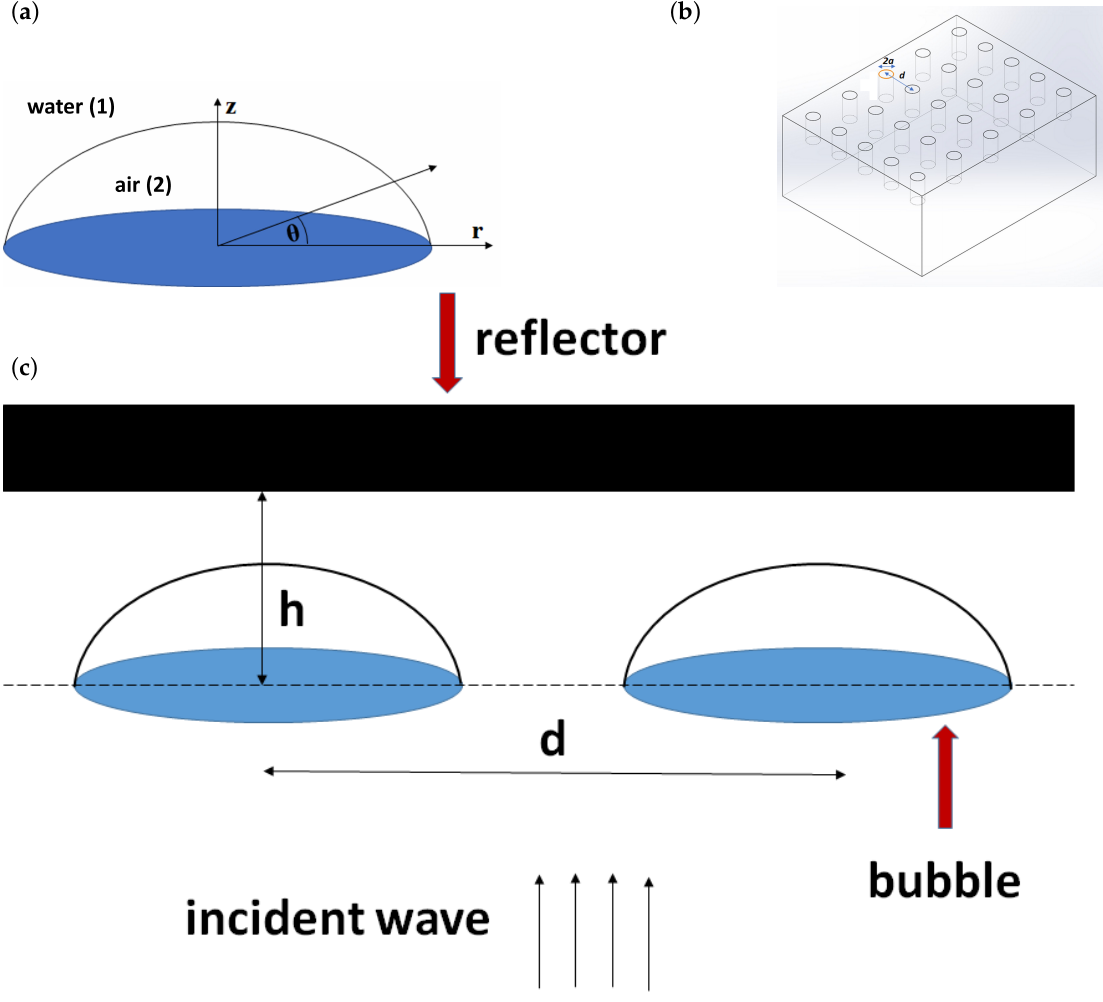
Figure 1. Domain definition for ( a ) single bubble; ( b ) bubble array; ( c ) bubble array with reflector. Numbers 1 and 2 in ( a ) correspond to subscripts in Equation